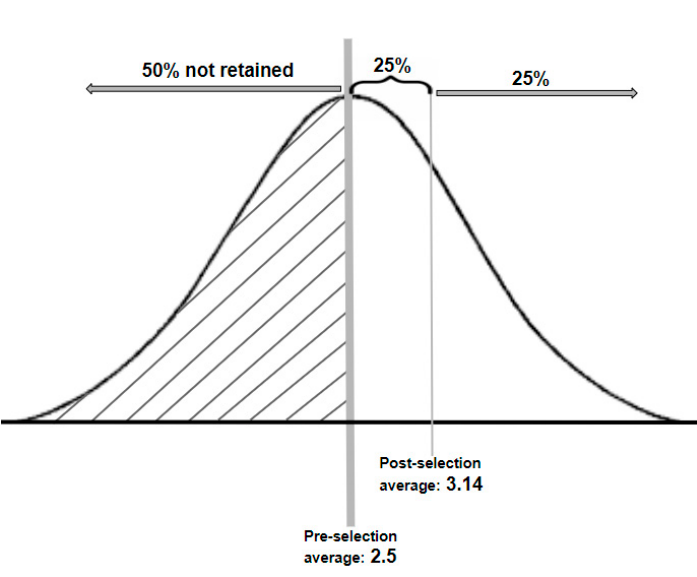
Figure 2. Simplified example of the effect of a selection intensity of 50% on the average shedding score in ½W½R ewe lambs from Romney dam with a score of 0 and Wiltshire sire with a score of 5.